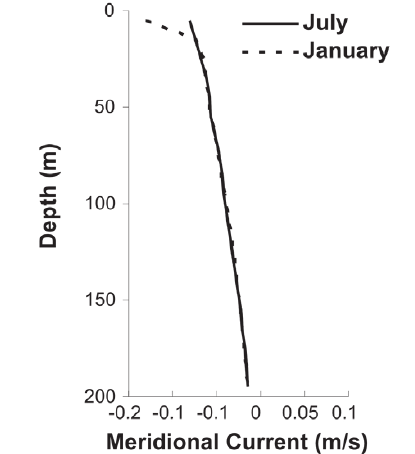
Figure 3 - Modular Ocean Model output of the vertical profiles for the meridional current velocity (North-South) for one point on the grid near the mooring position off the Brazilian coast (23° S) during January and July from 1963 to 2003. T HE D YNAMIC D ESIGN